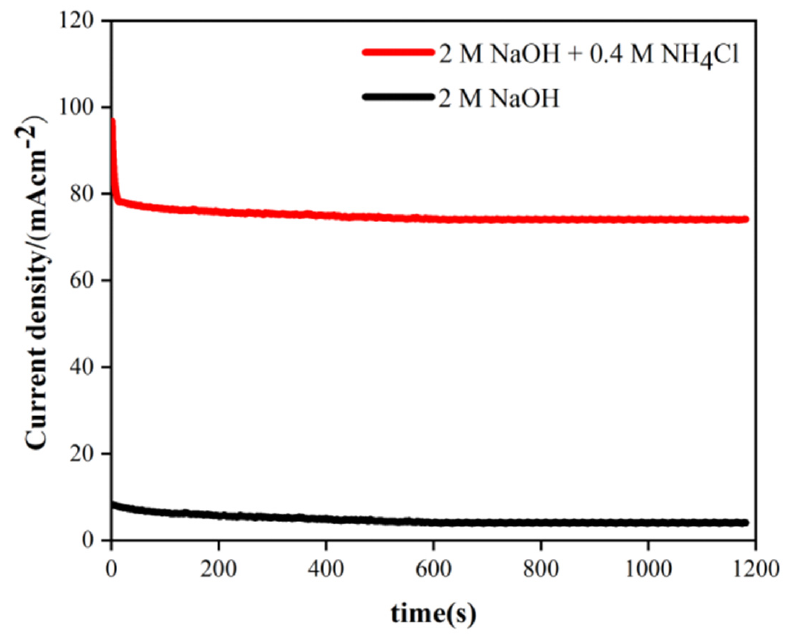
Figure 5. The comparison of i-t curves obtained on the NiCuOOH-NF electrode at 0.6 V vs. SCE in 2 M NaOH + 0.4 M NH 4 Cl or 2 M NaOH.